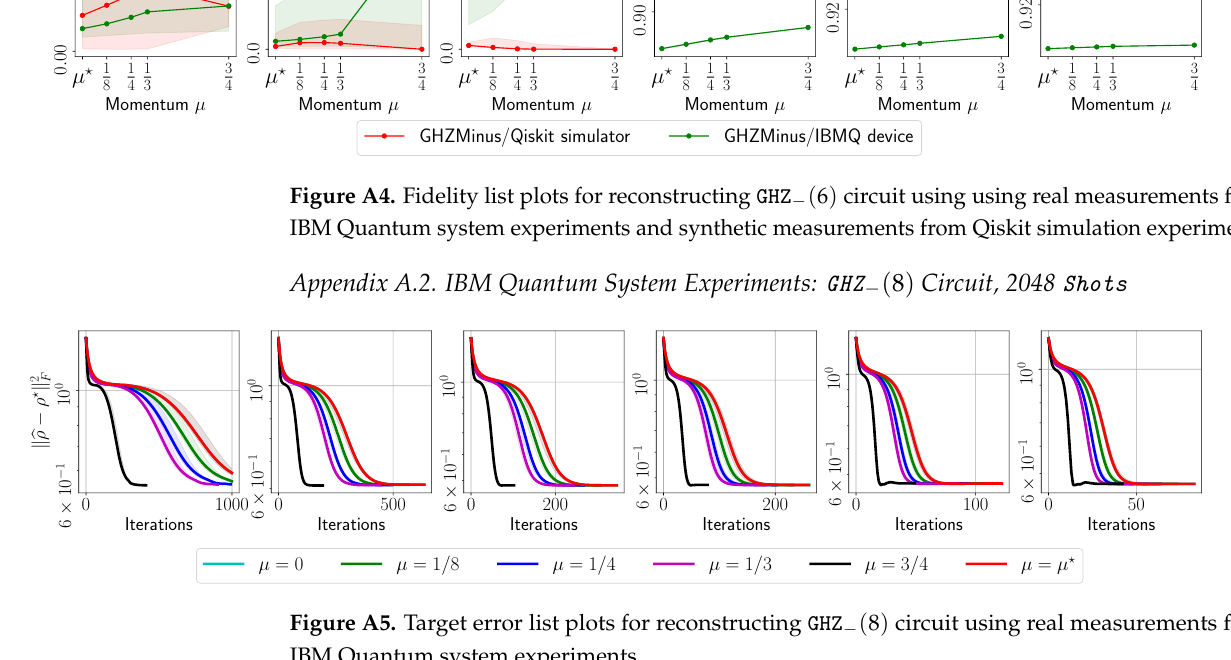
Figure A5. Target error list plots for reconstructing GHZ IBM Quantum system experiments.